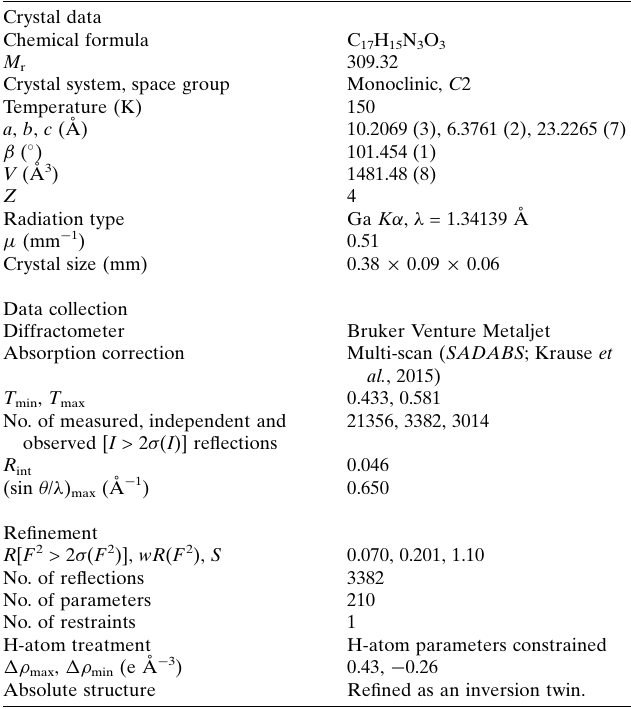
Crystal data Chemical